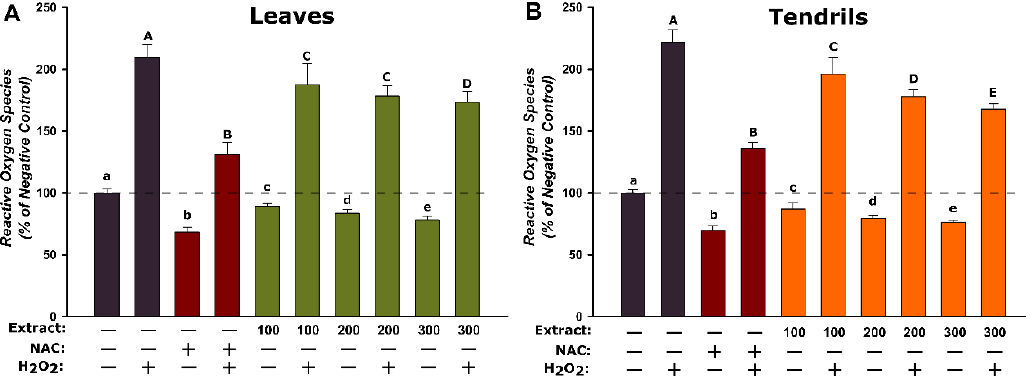
Figure 3. Antioxidant effect of the LE ( A ) and TE (B ) evaluated using DCFH-DA assay on HGF cells. The cellular model was pre-exposed to LE and TE (100, 200, and 300 µg/mL) or NAC (20 mM) for 24 h, and further incubated with 50 µM DCFH-DA. The antioxidant effect was evaluated after 2 h on stimulated (250 µM H 2 O 2 ) and un-stimulated conditions. The results are expressed as relative means ± standard deviations (six technical replicates for each of the three biological replicates) where the negative control (DMSO 0.2%) is 100%. Different letters (a – e refers to comparisons on non-stimulated conditions, whereas A – E refers to comparisons on stimulated conditions) represent significant differences (ANOVA + Holm-Sidak post hoc test at p < 0.05 level of significance).